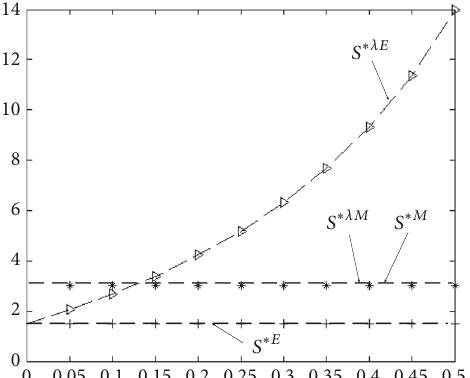
Figure 9: Change rule of manufacturer’s profit as 𝜆 changes.